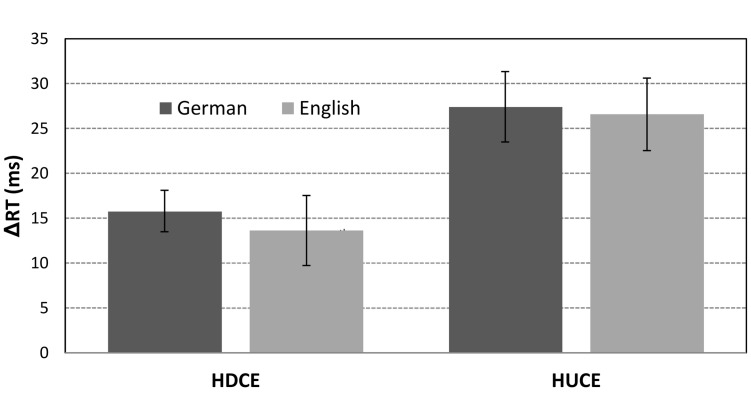
Effects of hundred-decade (HDCE) and hundred-unit compatibility (HUCE) for German- and English-speaking adults. Error bars represent standard errors.